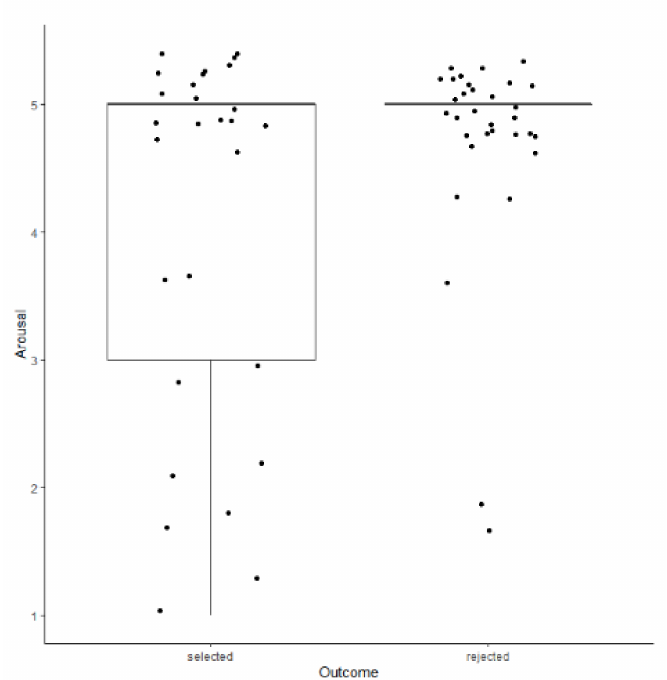
Figure 1. Distribution of ratings for Working Arousal (1–5 scale) in the Performance Test for 3-months-old puppies as a function of eventual program outcome. Horizontal lines represent medians, boxes represent the interquartile range, and whiskers represent the range of values within 1.5 × interquartile range. Dots are individual data points, jittered to reduce